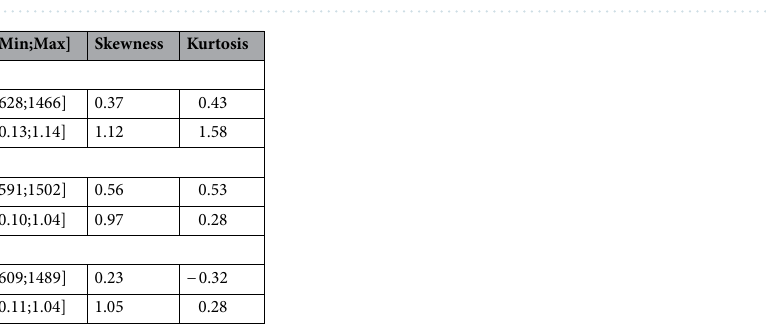
Figure 4. Graphical representation of the linear regression of the effect of diet control on the difference in time estimate between (left panel) BP